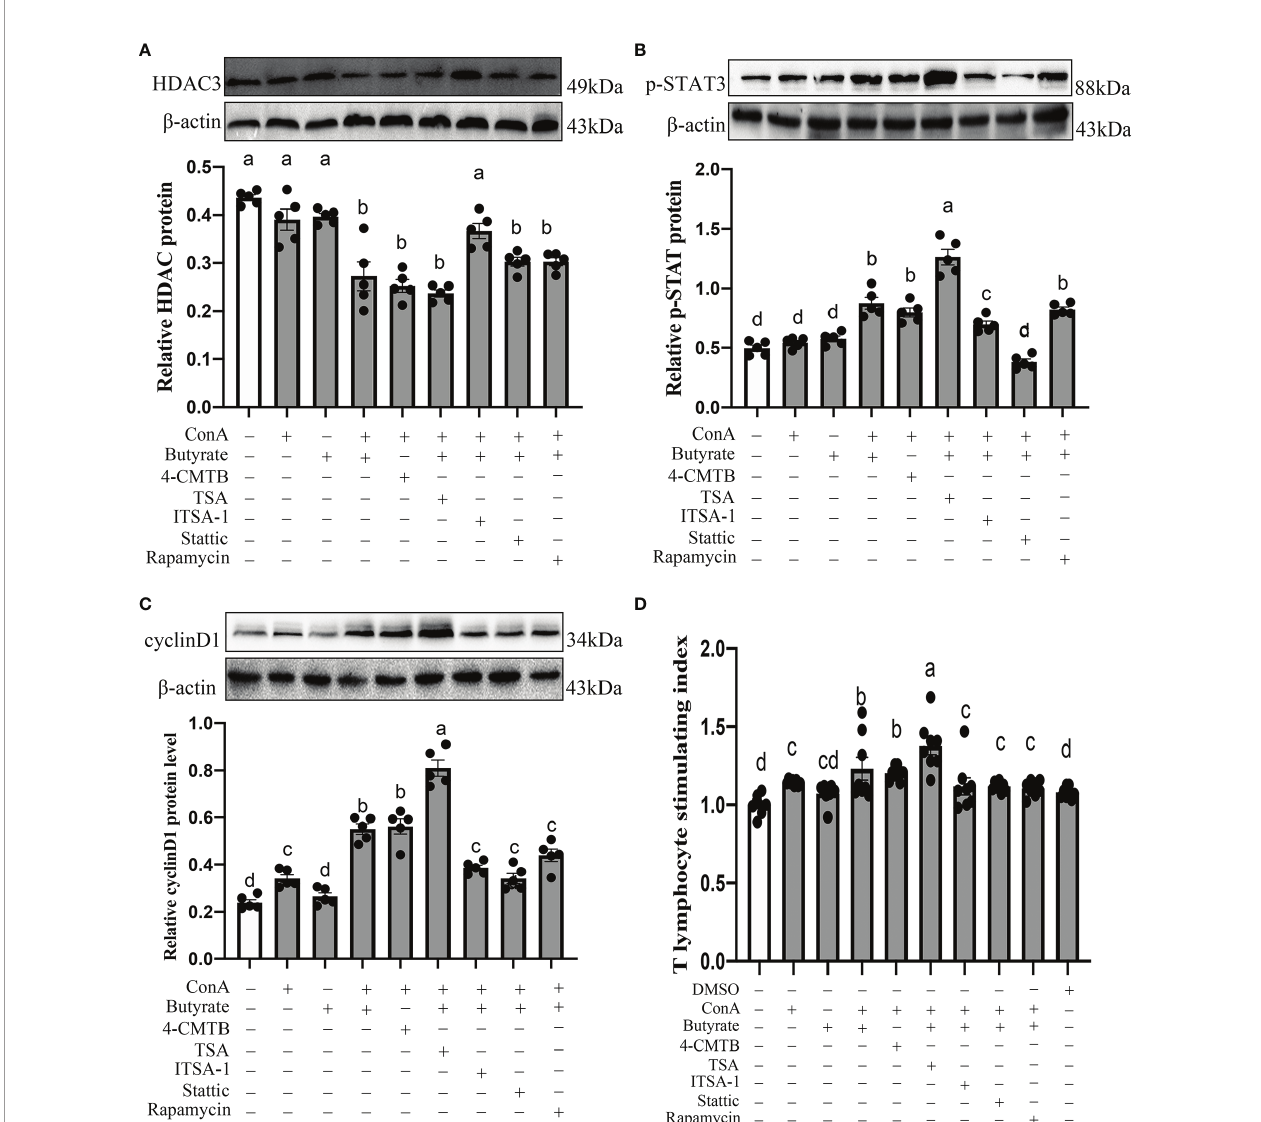
FIGURE 11 | Effects of GPR43 agonist, HDAC3 antagonist, HDAC3 agonist, STAT antagonist, and mTOR antagonist on HDAC3 protein level (A) , p-STAT3 protein level (B) , cyclin D1 protein level (C) , and cecal tonsil T proliferation stimulation index (D) . 4-CMTB is a GPR43 agonist, TSA is a HDAC3 antagonists, ITSA-1 is a HDAC3 agonist, Stattic is a STAT3 antagonists, and rampamycin is a mTOR antagonists. Values with no common letters are signi fi cantly different ( P < 0.05) from each other. p-STAT3, phosphorylated